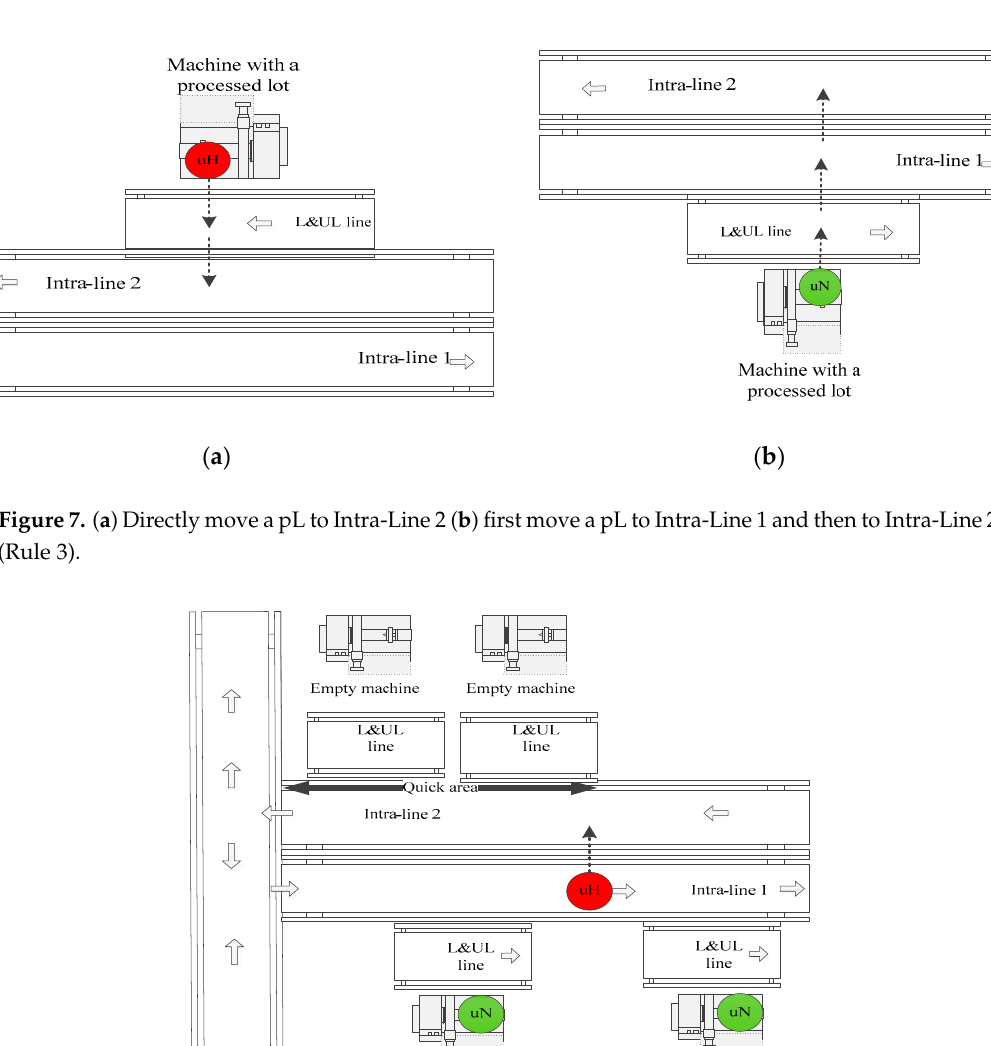
Figure 9. Directly move an uL to Intra-Line 1 from Intra-Line 2 (Rule 5).